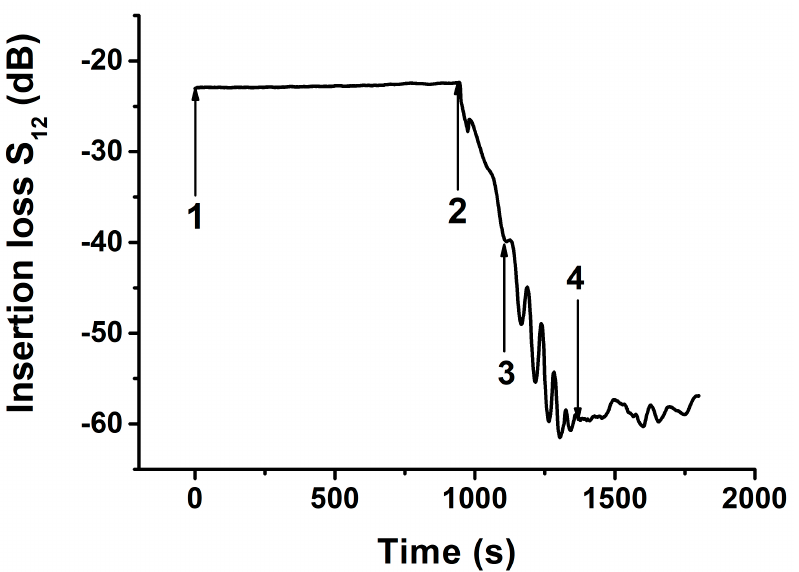
Figure 6. Time variation of the insertion loss S 12 of the delay line coated with distilled water measured for fluent cooling from +20 °C to − 15 °C in intervals of 5 °C with a pause of 60 s at each temperature. 1—The start of the cooling, 2—The start of the ice formation ( − 5 °C, 900 s), 2, 3, 4—water-ice two-phase system (from − 5 °C to − 15 °C, 900–1300 s), 4-homogeneous ice phase ( − 15 °C, >1300 s). Y,Z-LiNbO 3 plate, h / λ = 1.67. Mode: f n = 38.4 MHz. The position of the water (ice) sample on the plate is shown in Figure 2a.